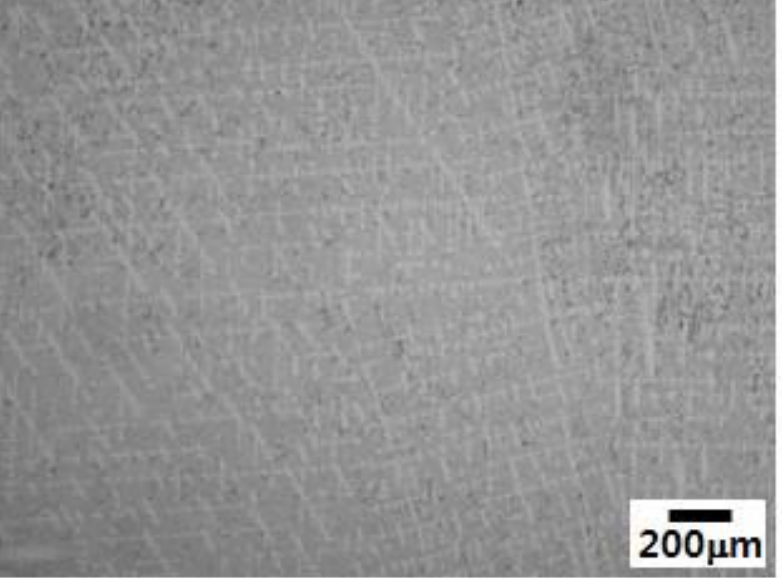
Figure 2. Optical micrographs of 2.8 wt% C–26 wt% Cr white iron showing poly crystalline and mixed structure of primary austenite and eutectic phase.